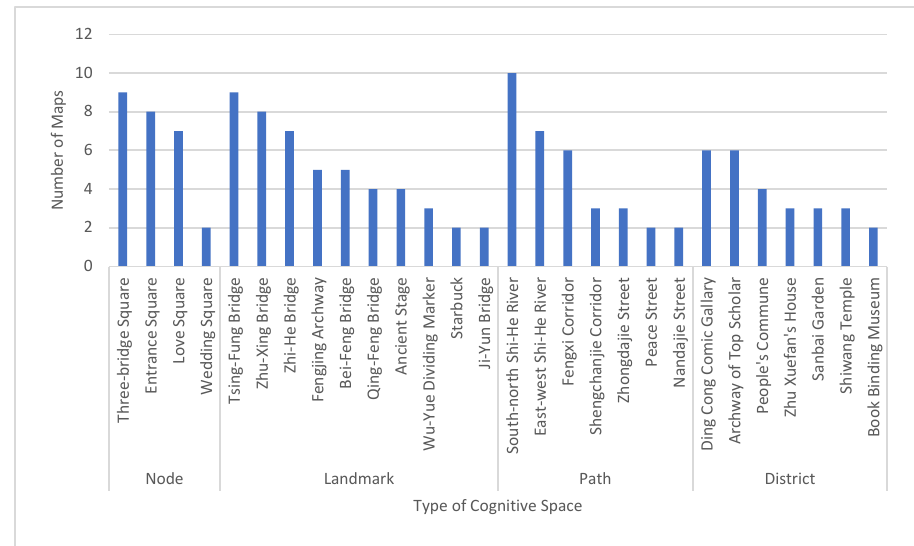
Figure 8. The frequency statistics of 9 cognitive space categories (source: authors).